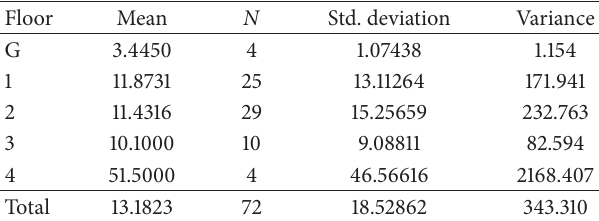
Table 3: Mean and variance of cockroach tap counts for surveyed floors of four surveyed buildings (72